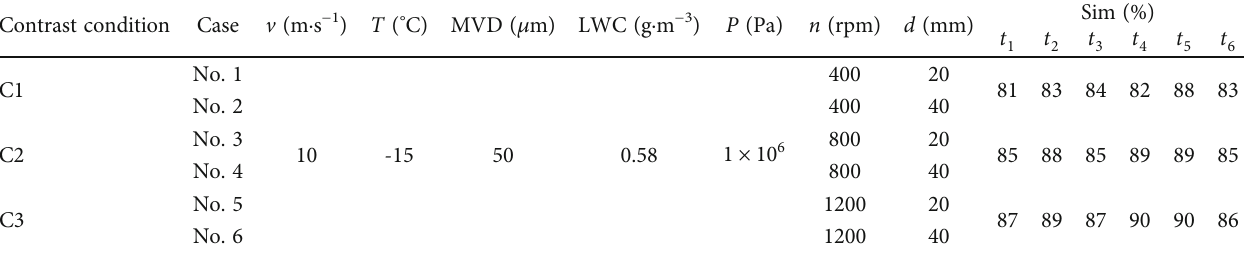
Table 2: Similarity rate of di ff erent conditions.